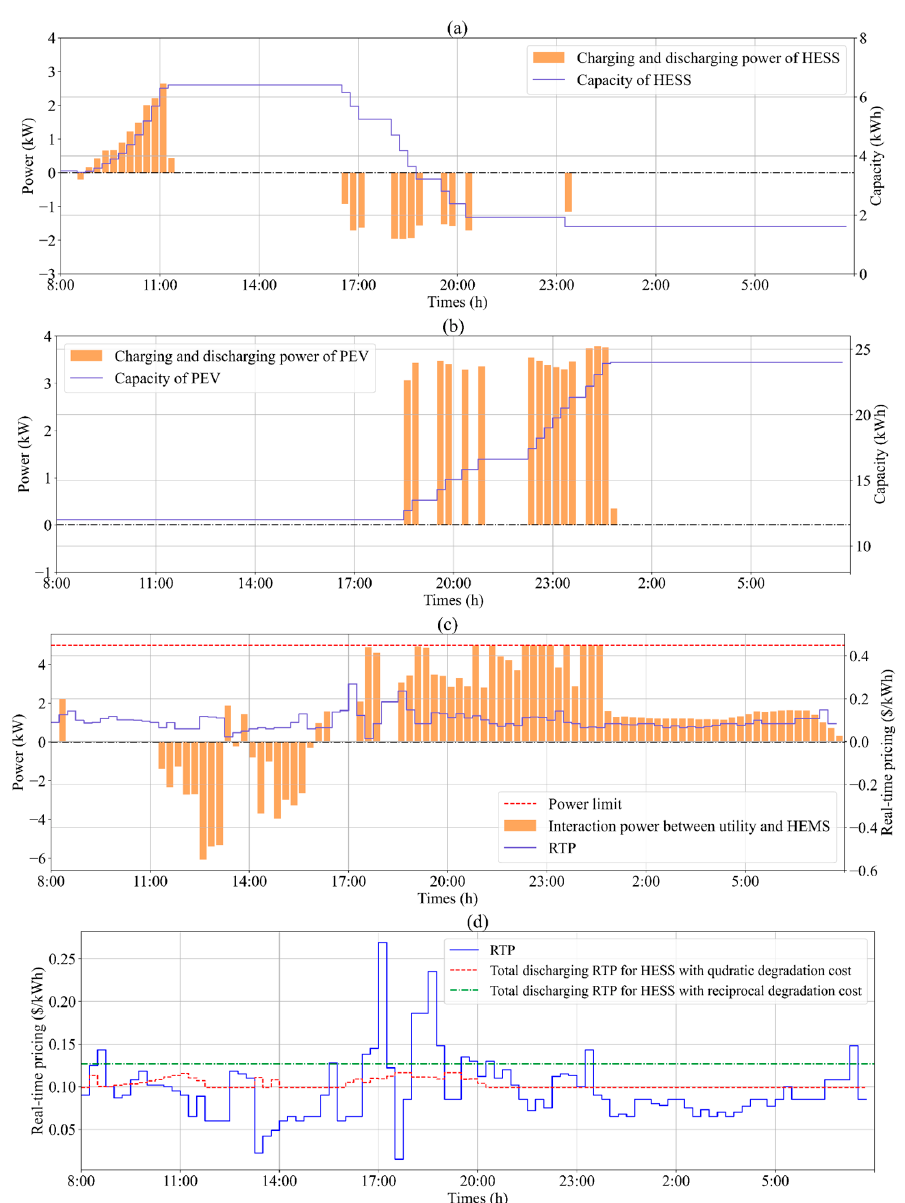
Figure 14. Load profiles for ( a ) HESS in HESS2H mode, ( b ) PEV in G2V mode, ( c ) H-MG without mode segmentation strategy, and ( d ) RTP comparison of HESS considering degradation cost.